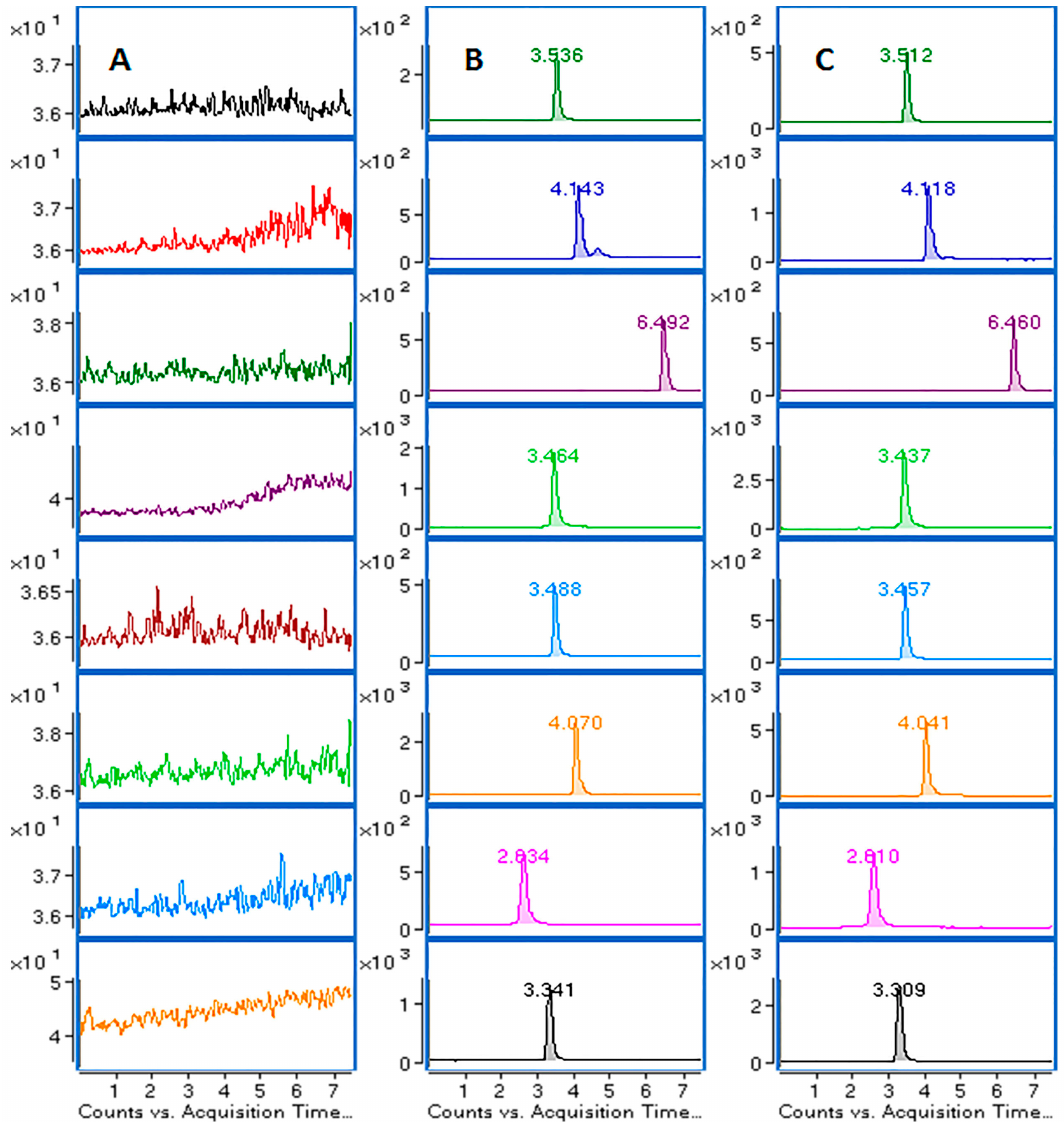
Figure 2. The chromatograms of the seven analytes and IS in rat plasma: ( A ) blank plasma; ( B ) blank plasma spiked with standard compounds (Medium Quality Control, MQC) and IS; ( C ) plasma sample from rat at 0.75 h after oral administration of E. purpurea extract; channel 1 for syringic acid; channel 2 for ferulic acid; channel 3 for IS; channel 4 for caffeic acid; channel 5 for vanillic acid; channel 6 for p -coumaric acid; channel 7 for 3,4-dihydroxybenzoic acid and channel 8 for 4-hydroxybenzoic acid.